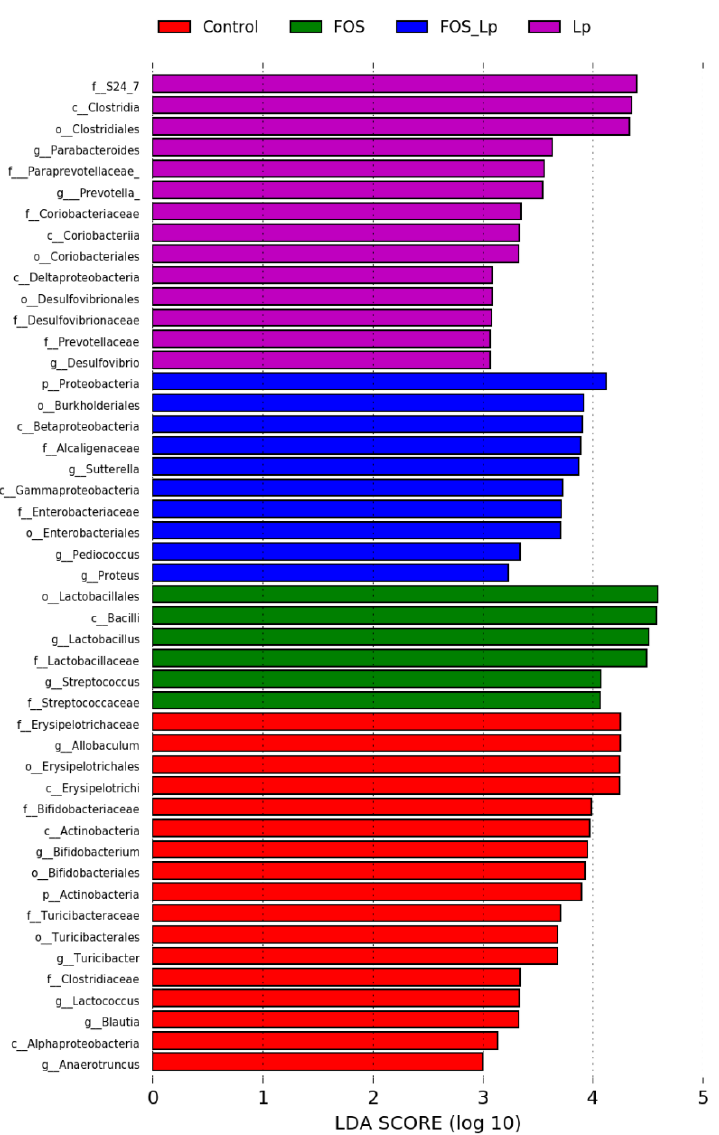
Figure 3. The LDA score is based on LEfSe analysis of the intestinal microbiota in the different